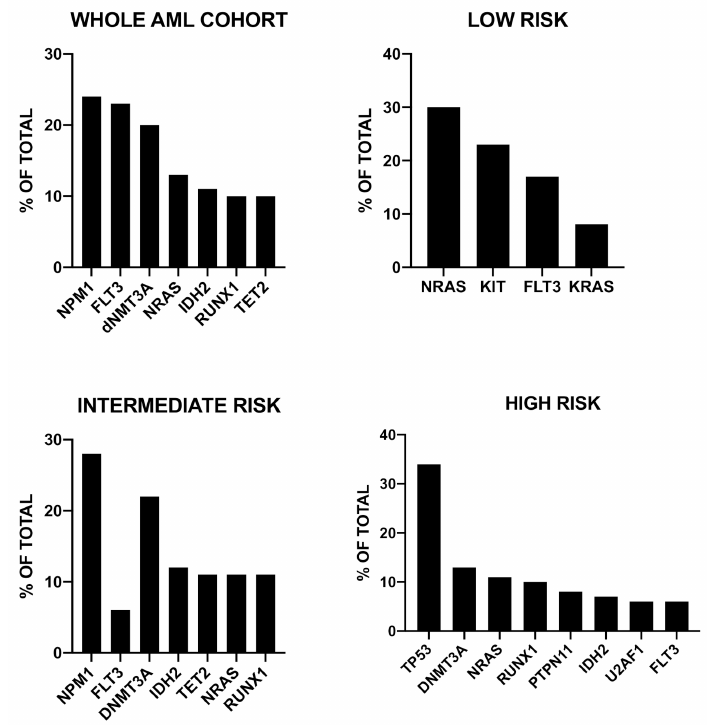
Figure 2. Recurrent genetic abnormalities observed in 6788 AML patients stratified into four prog- nostic risk groups (low risk, intermediate-low risk, intermediate-high risk and high risk), according to a machine learning algorithm. The data are reported in Awada et al., 2020